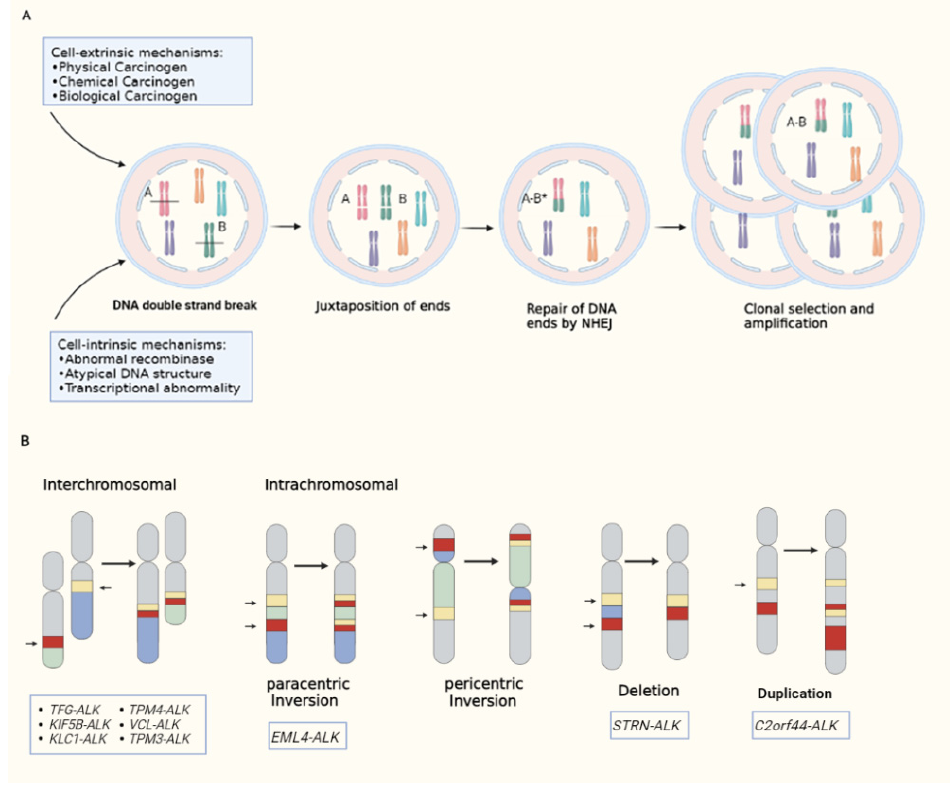
Figure 1. ( A ): Generation of pathogenic fusion genes; ( B ): types of ALK rearrangement.